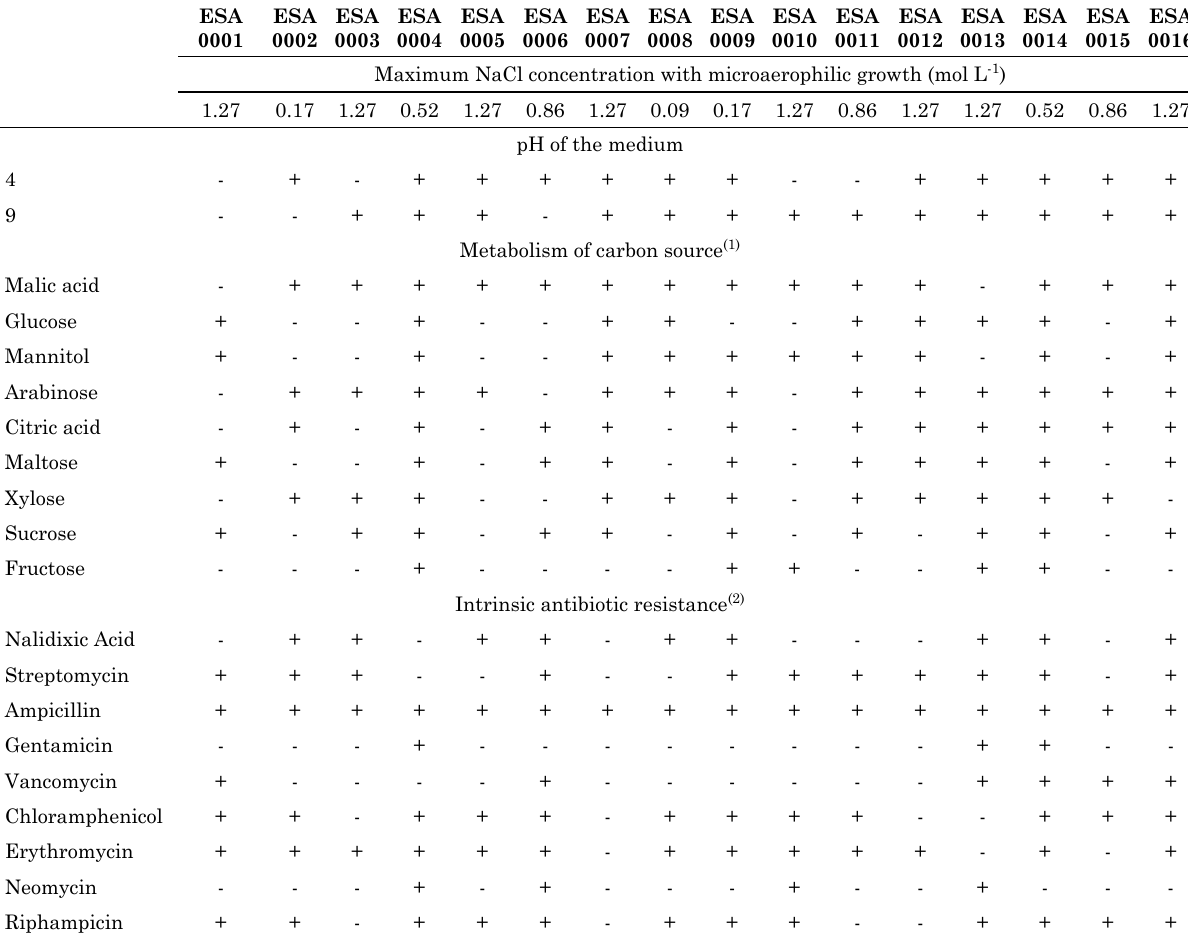
Table 3. Tolerance to different concentrations of nacl and phs in vitro , ability to metabolize nine carbon sources, and intrinsic resistance to different antibiotics for 16 bacteria isolated from Tripogon